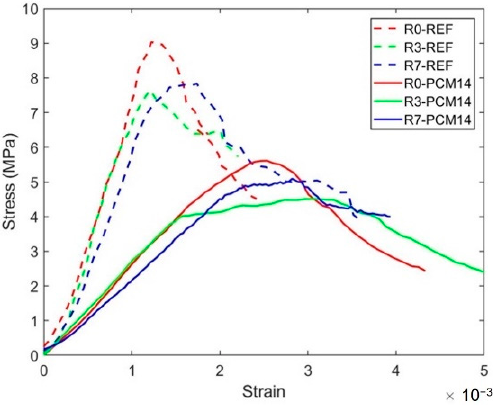
Figure 17. Stress–strain curves of the LCCCs on the out-of-plane direction obtained both from the REF specimens and PCM14 specimens, measured by H20 specimens.